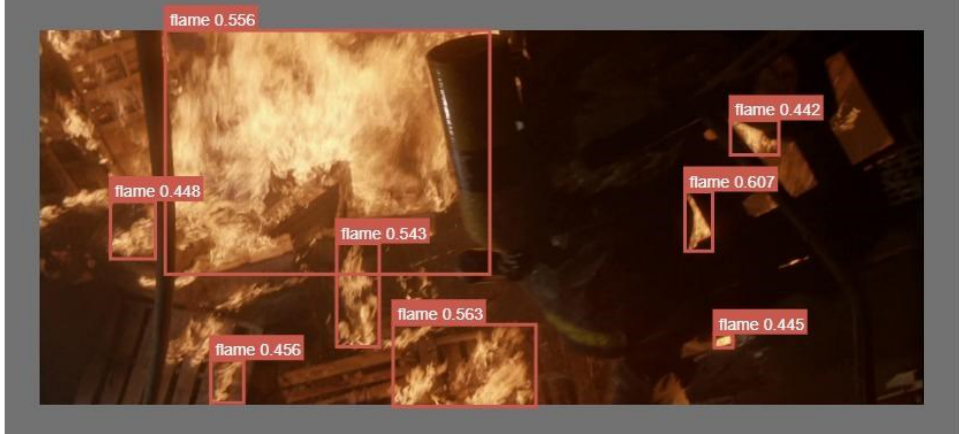
Figure 11. Example of object detection with probabilities using YOLOv5.